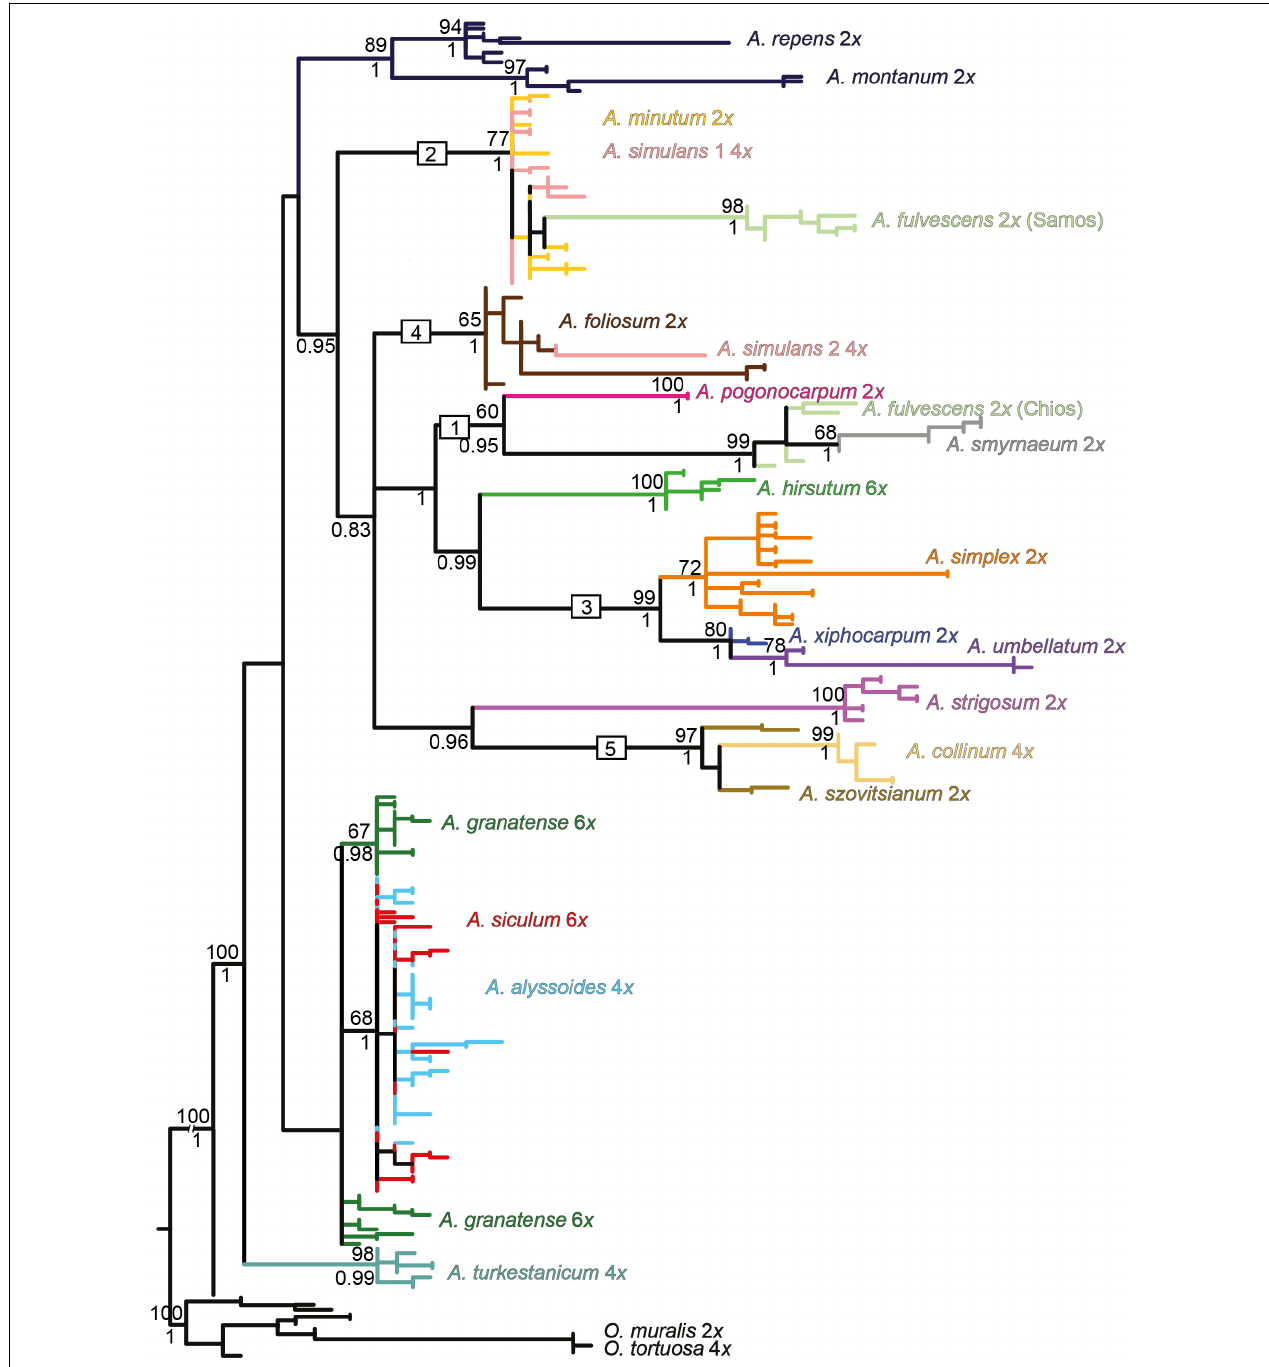
FIGURE 5 | Maximum-likelihood tree based on the ITS sequences of nrDNA for the studied Alyssum species. For the tree description, see the legend of Figure 4 . Divergent ITS sequences were observed in the tetraploid A. simulans , which are placed in distinct clades (nr. 2 and 4), marked here as A. simulans 1 and A. simulans 2. The fully labeled version of the tree is shown in Supplementary Figure 2A